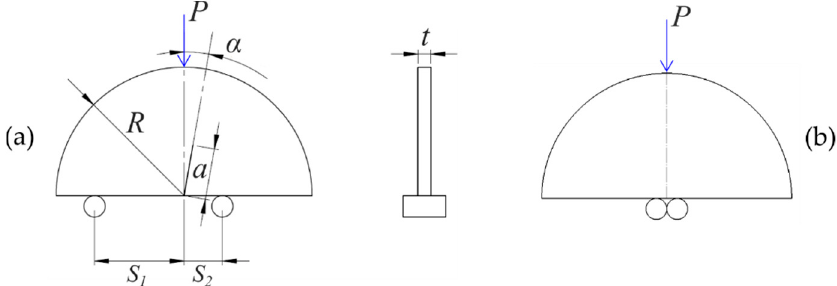
Figure 1. Geometrical features and loading conditions of the inclined asymmetrical semicircular specimen subjected to three points loading (IASCB) specimen; ( a ) fracture test; ( b ) indentation test.